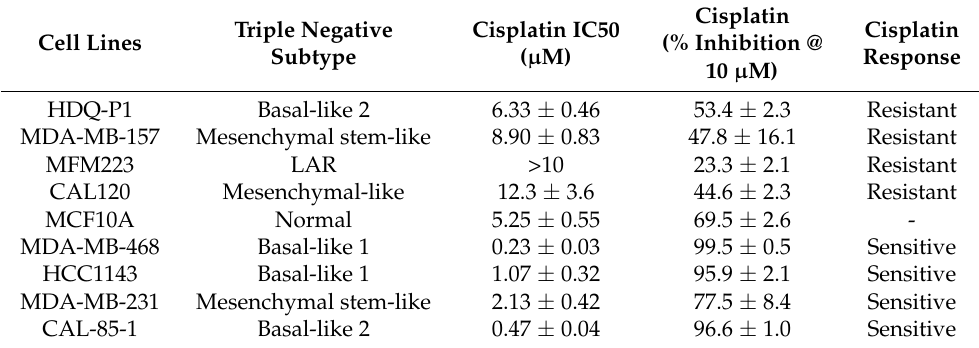
Table 2. Cisplatin sensitivity in a panel of TNBC cell lines as determined by the acid phosphatase